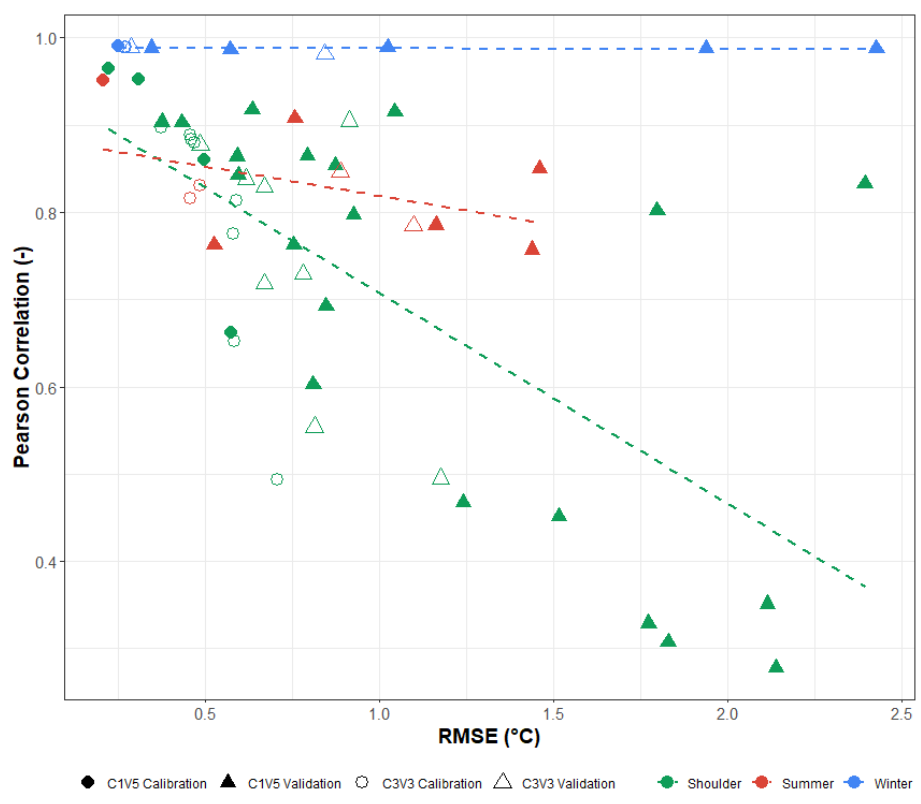
Figure 10. Scatterplots of Pearson correlation co-efficient and RMSE for both GB calibration methods (C3V3 and C1V5). Points indicate the accuracy for a single specific week for the GB model calibrated using different data sources, where, the colour indicates the season and the shape indicates the calibration method (C3V3 or C1V5) and whether it was a calibration or validation week. Dashed line indicates the line of best fit according to season.